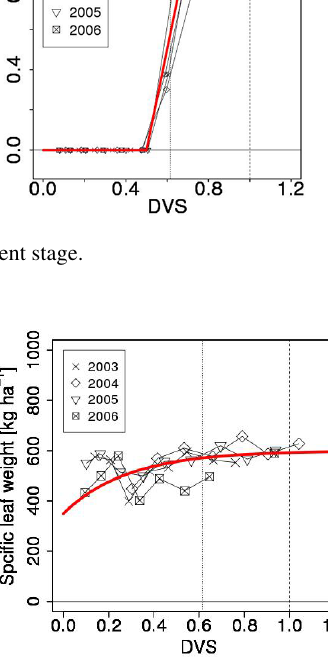
Figure 3. Ratio of dead leaves. A red line is fitted. D vs indicates the development stage.